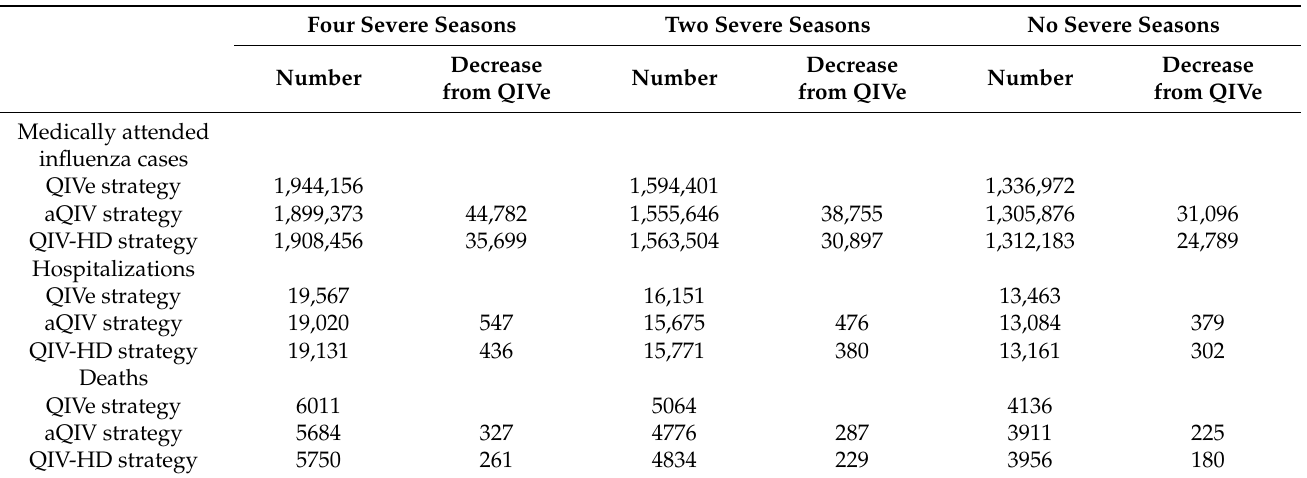
Table 3. Base case results: predicted average number of annual influenza cases, hospitalizations and deaths when using QIVe, aQIV and QIV-HD in Germany by number of severe